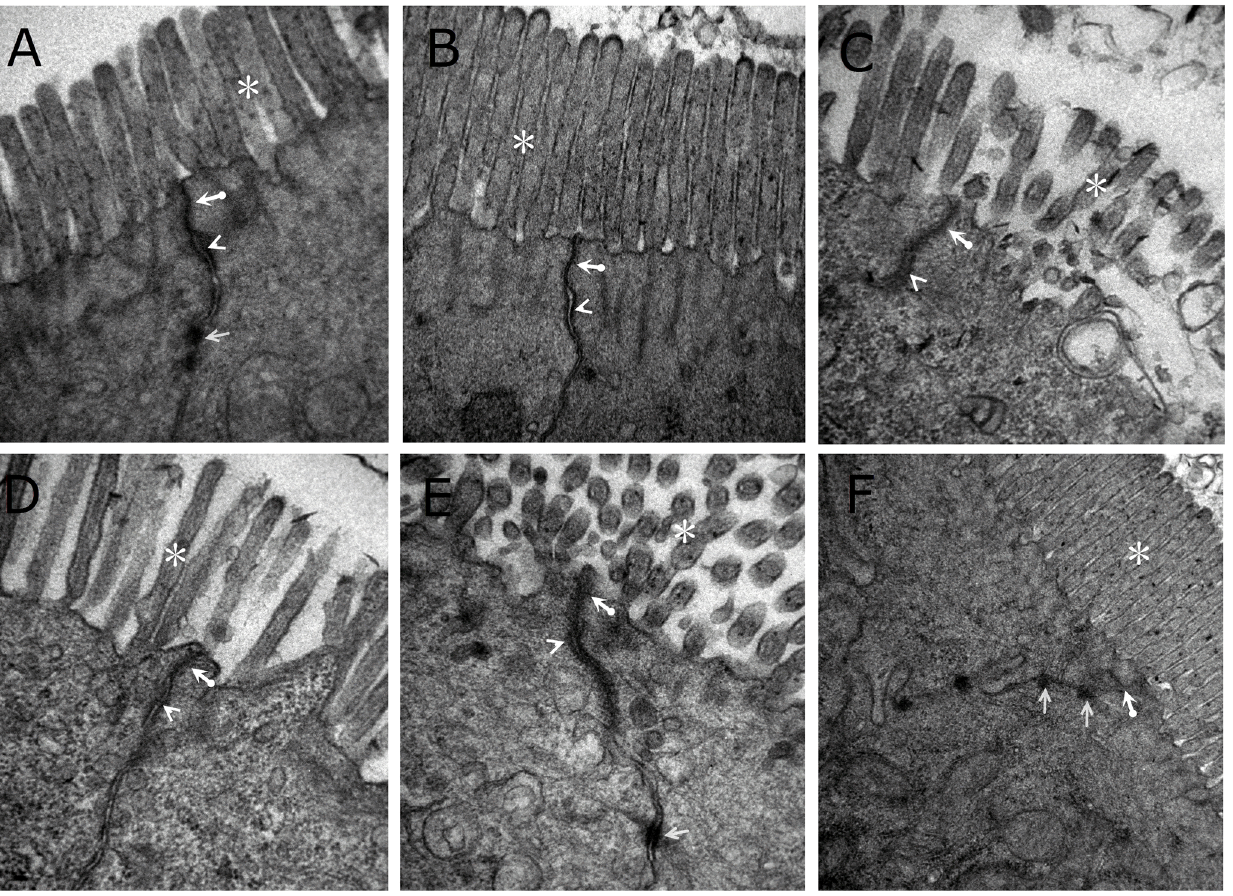
Fig 7. Representative photographs of transmission electron microscope of tight junctions in intestine (40 000X) from each group. (A) sham group. (B) S group. (C) LR group. (D) MT group. (E) HS group. (F) HES group. Thick arrows: tight junctions. Arrow heads: adherence junctions. Arrows: desmosome. Asterisks: